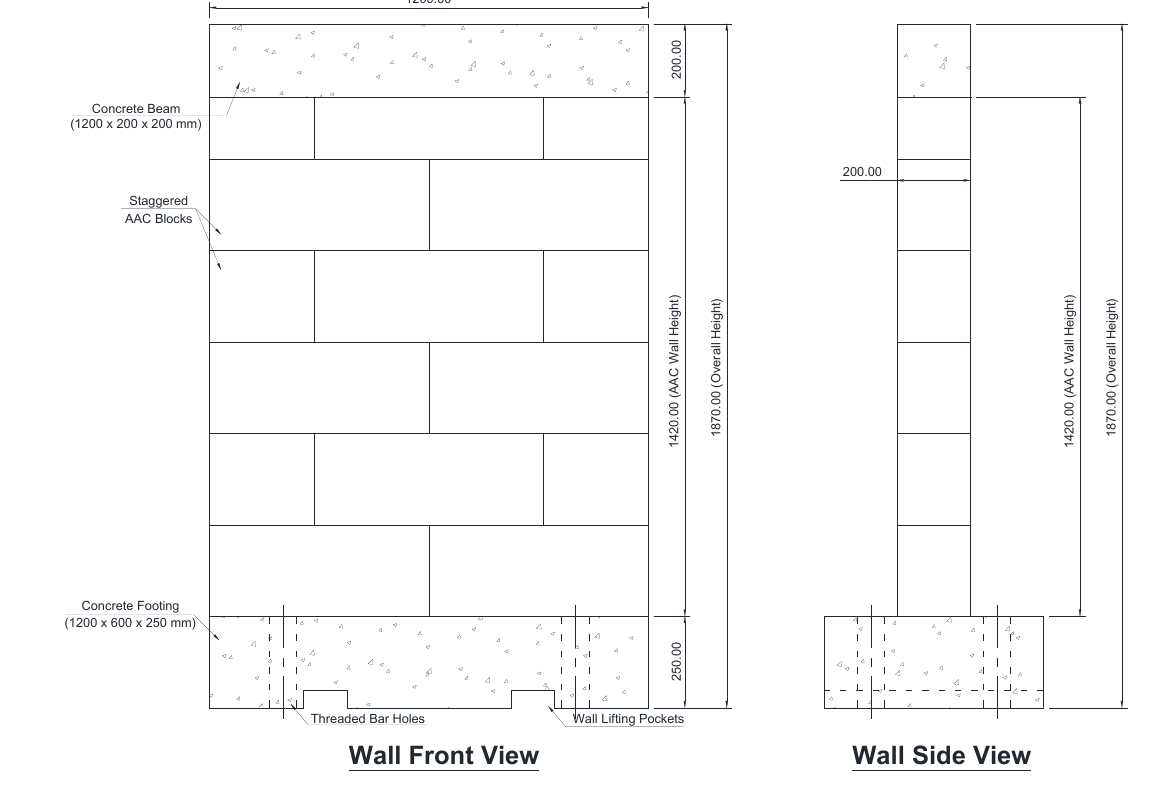
Figure 9. Details of the unreinforced wall with dimensions in mm.